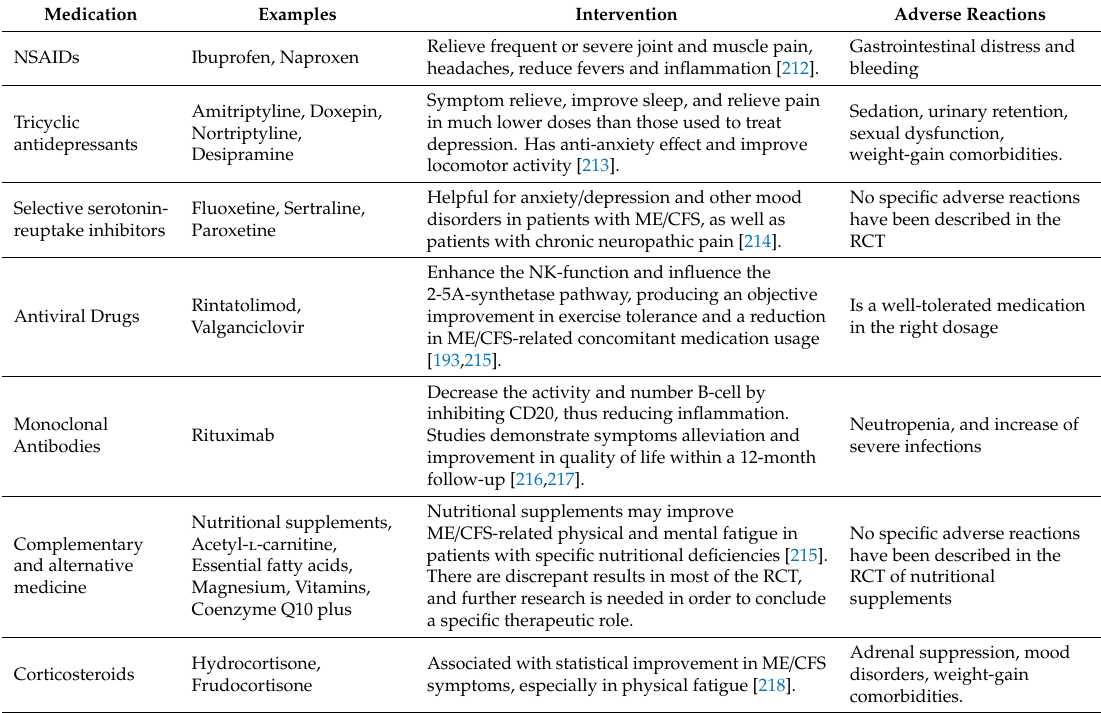
Table 3. Current therapeutic strategies for ME /